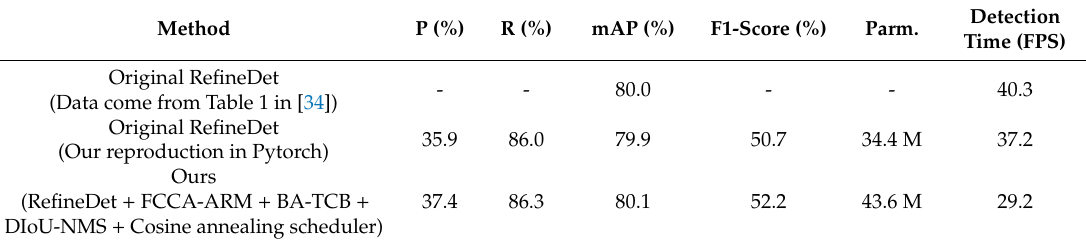
Table A1. Performance reults on PASCAL VOC2007 test